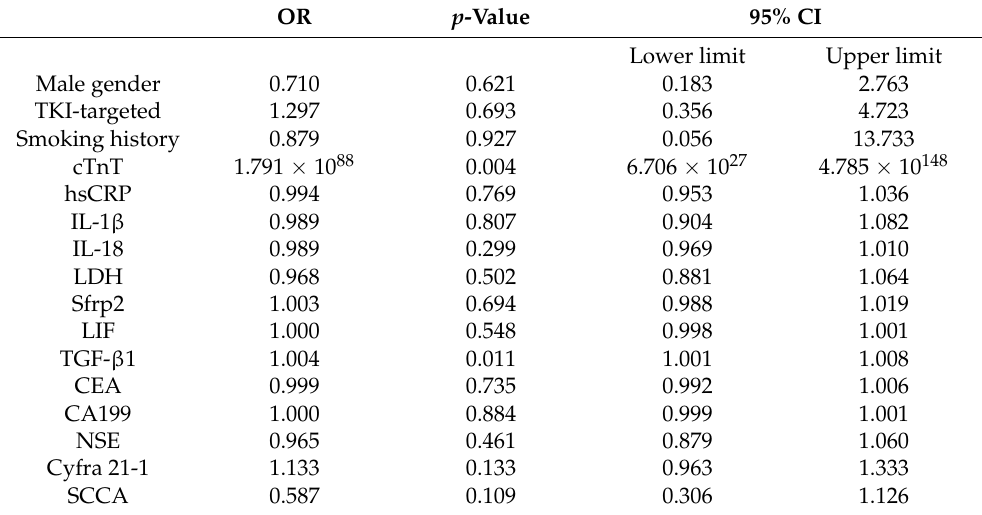
Table 2. Multivariable logistic regression results about the association between inflammatory biomarkers and preclinical cardiovascular injury in NSCLC patients.